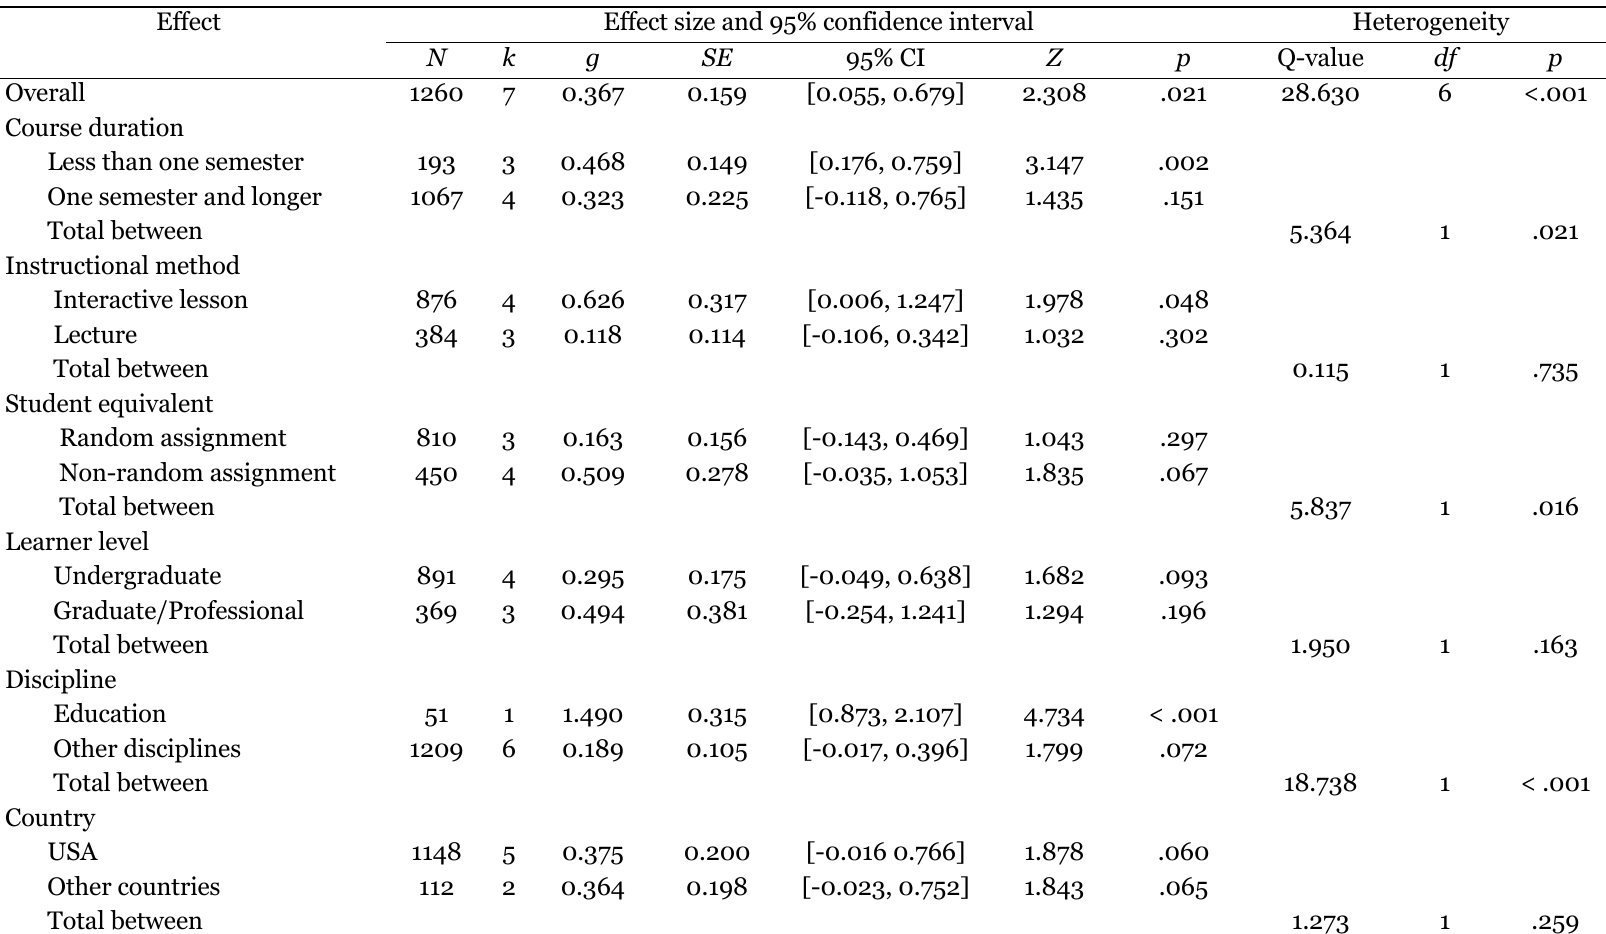
Moderator Analyses (Synchronous vs. Asynchronous Cognitive